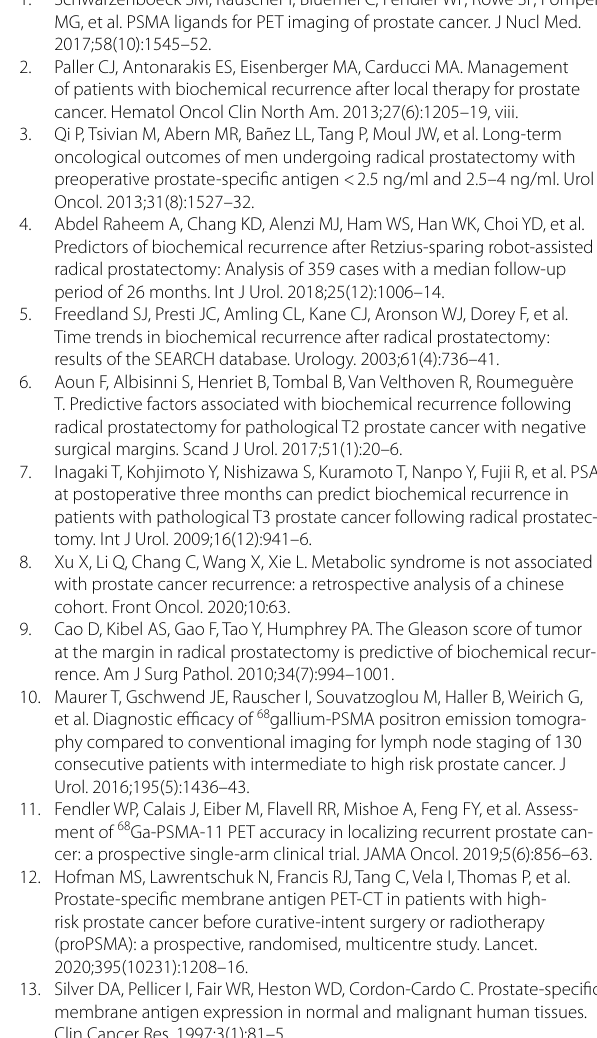
miN. Supplementary table 3. Univariate analysis for the association of 68 Ga‑PSMA‑11 PET findings with surgical margin status. Supplementary Fig. 1. Flowchart of inclusion and exclusion steps. Supplementary Fig. 2. Longer biochemical recurrence‑free survival was associated with (A) pT 2, (B) pN 0, (C) Gleason Score < 8 and (D) negative surgical = =